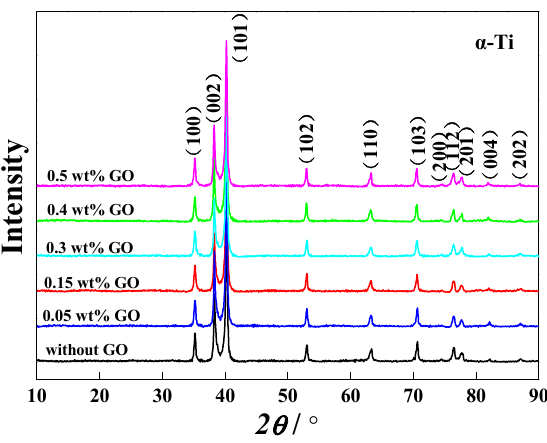
Figure 6. XRD patterns of the composites with different addition amounts of GO.